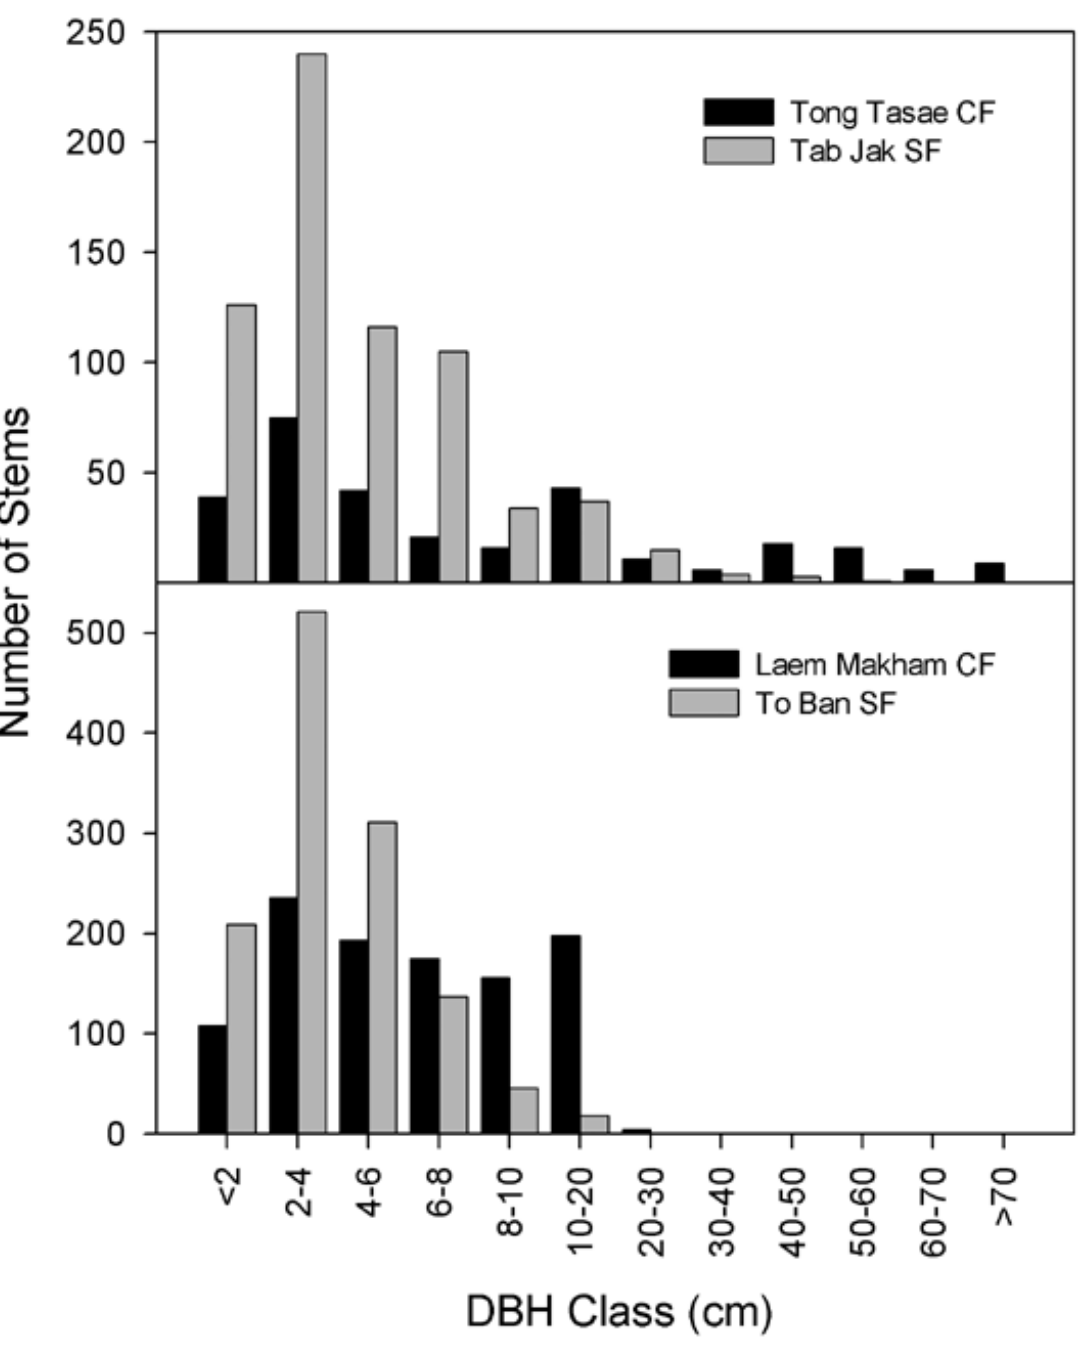
Fig. 2. The diameter-at-breast-height (dbh) class distribution of the tree communities in community- and state-managed mangrove forests in Trang, southern